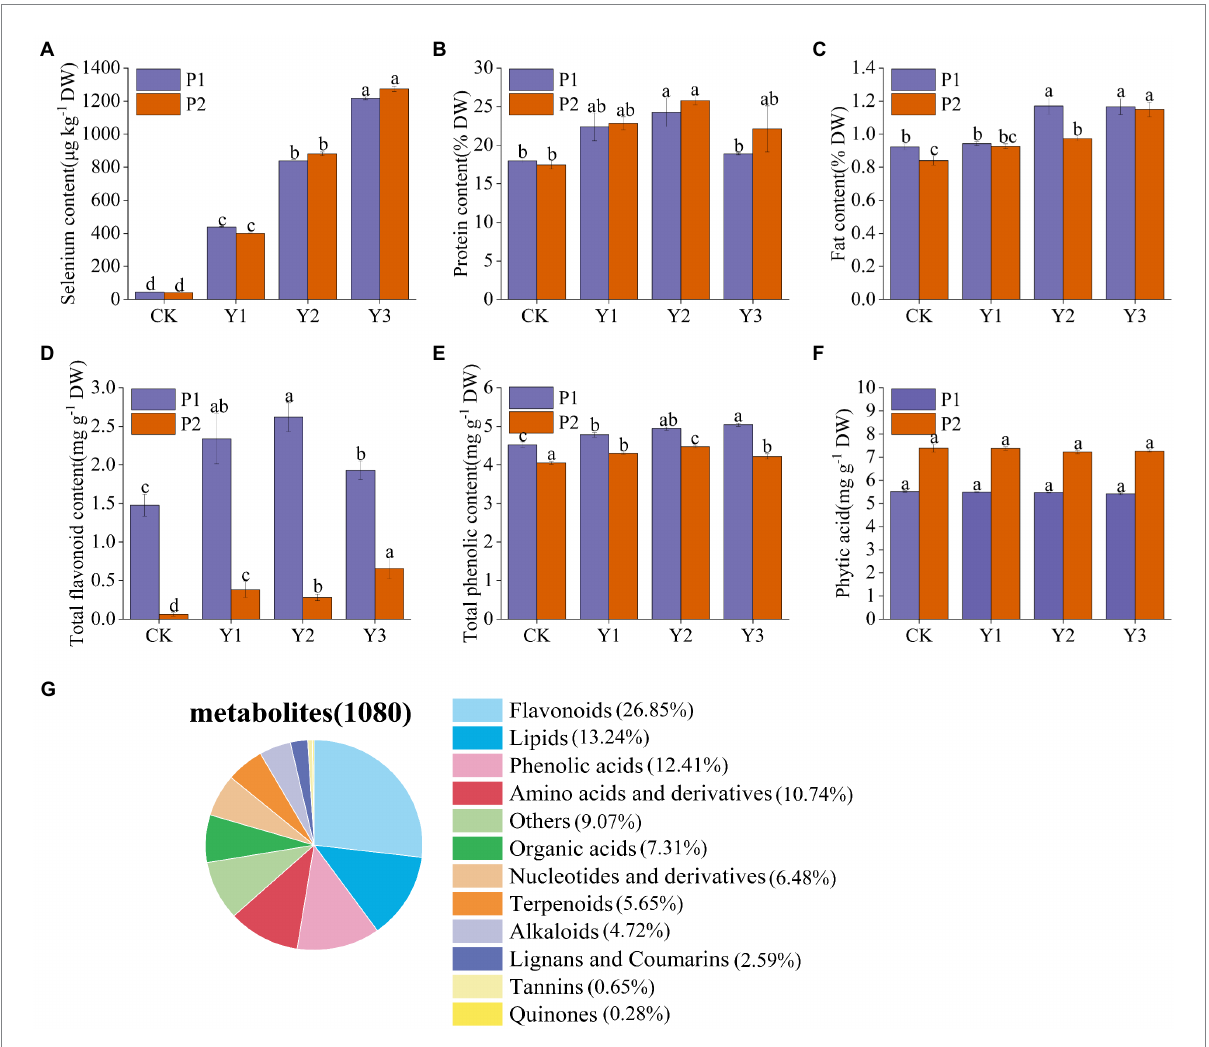
FIGURE 1 Effects of Se fertilization on Se content of mung beans (A) , protein (B) , fat (C) , total flavonoids (D) , total phenols (E) , phytic acid (F) , and classification of 1,080 metabolites identified in mung bean samples (G) . Data represent mean values ± SD of three independent measurements. Different letters indicate significantly different values ( p <